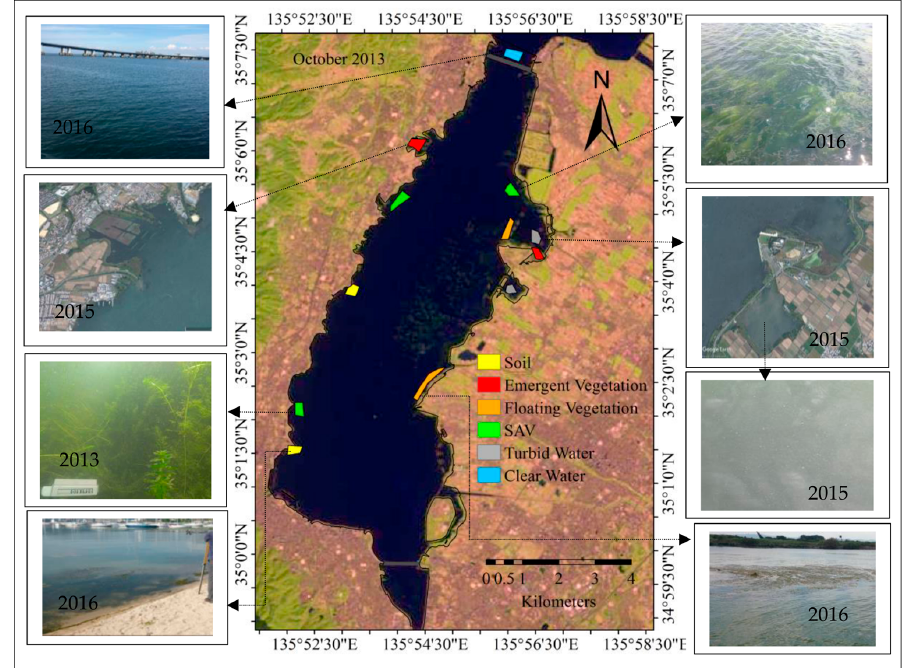
Figure 8. The selected common locations in the study area represent the specific class (for training and validation) for classification (2013–2016). From each location, pixels were manually selected. The images were obtained from the Japan Water Agency (JWA), Lake Biwa Environmental Research Institute (LBERI), the in situ measurements (September 2016) and Google Earth Pro version 7.3.0. The natural color image used in the map is from October 2013, and Google Earth image is from August 2015.